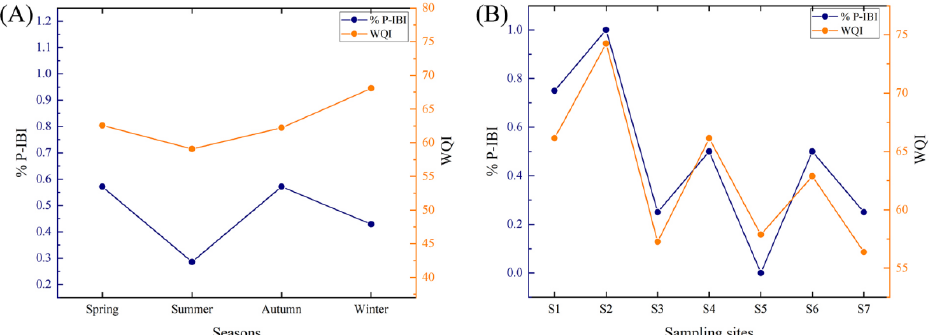
Figure 7. Comparison of % P–IBI and WQI evaluation results. ( A ) Comparison of % P–IBI and WQI evaluation results in different seasons. ( B ) Comparison of % P–IBI and WQI evaluation results at different sites. % P–IBI indicates the percentage of sampling sites with P–IBI evaluation results exceeding the “moderate”